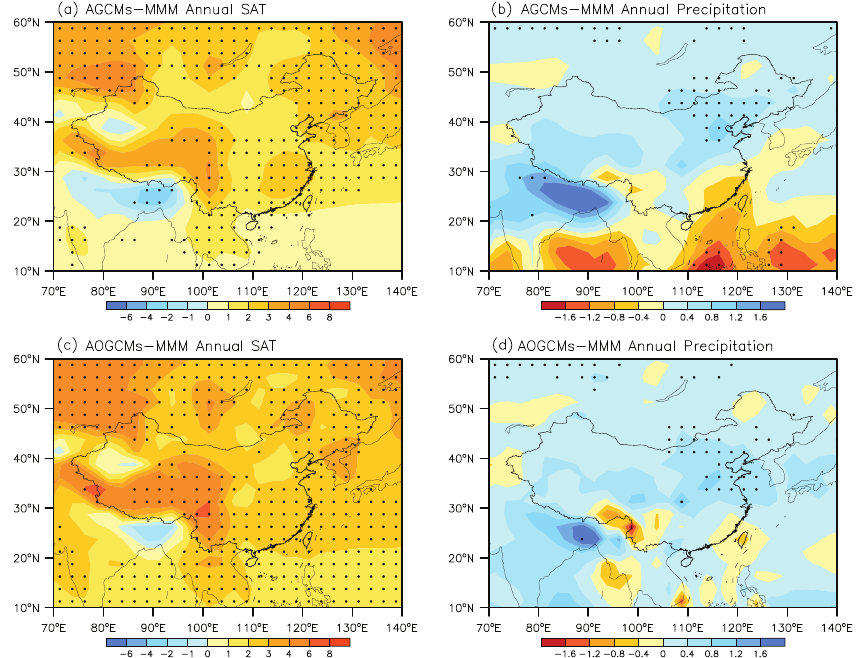
Fig. 7. Same as Fig. 5, but for annual mean SAT (left column, units: ◦ C) and precipitation differences (right column, units: mmday − 1 ) . The areas with confidence levels larger than 95% using Student’s t test are